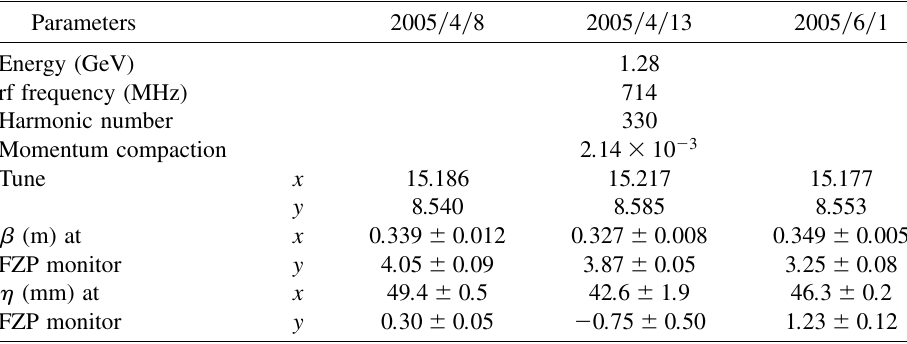
TABLE IV. Summary of the parameters of the damping ring (measured value). The x ( y ) in the second column of parameters denotes the horizontal (vertical) direction of each parameter (Tune, (cid:7) function, and dispersion function).